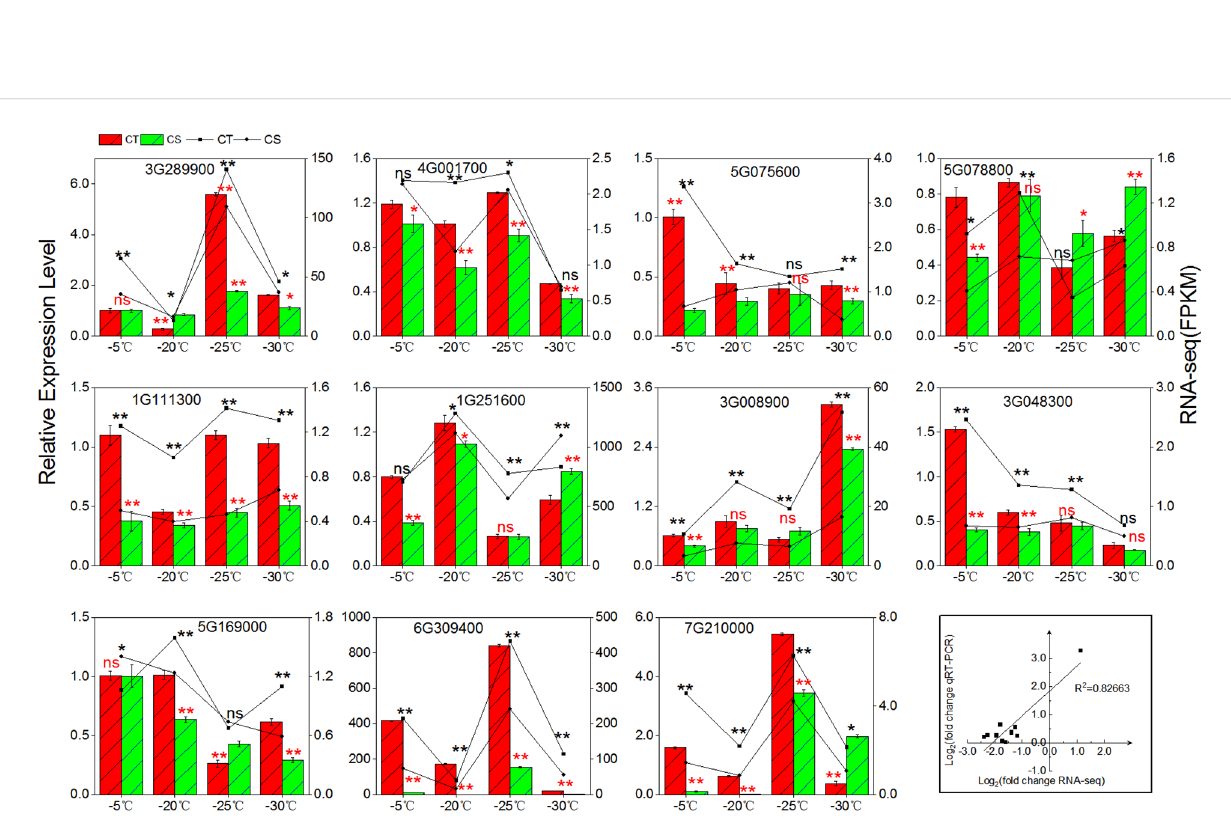
FIGURE 7 qRT-PCR validation. For the bars with standard errors and broken lines, log2 value of gene changes and log2 fold change were used for qRT-PCR and RNA-seq from three independent biological replicates (n = 3) using the 2 ‾ DD CT method (left y-axis) and the FPKM value of RNA-Seq (right y- axis), respectively. ns, not signi fi cant; *, p < 0.05; **, p <